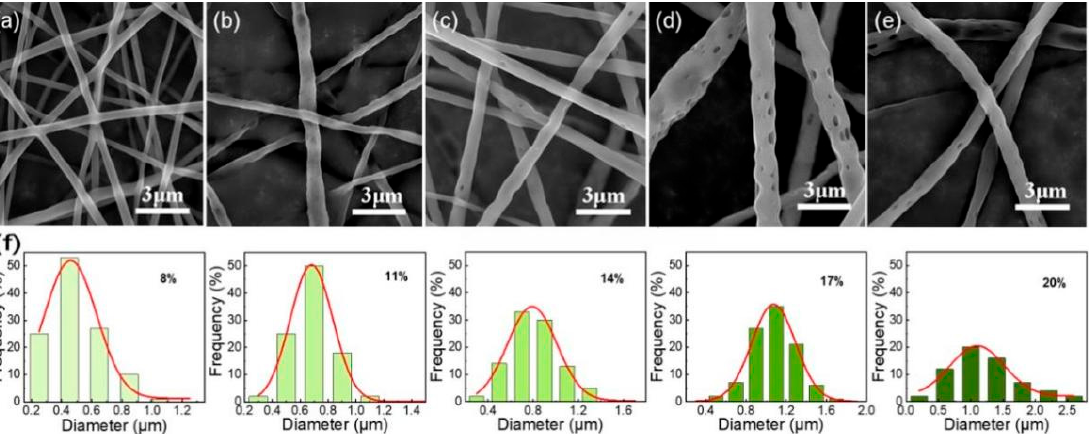
Figure 2. SEM images of the electrospun fibrous membrane with different PLLA concentrations (wt%), ( a ) 8%; ( b ) 11%; ( c ) 14%; ( d ) 17%; ( e ) 20%; ( f ) Gaussian fitting curve of fiber diameter distribution prepared under different solutions.